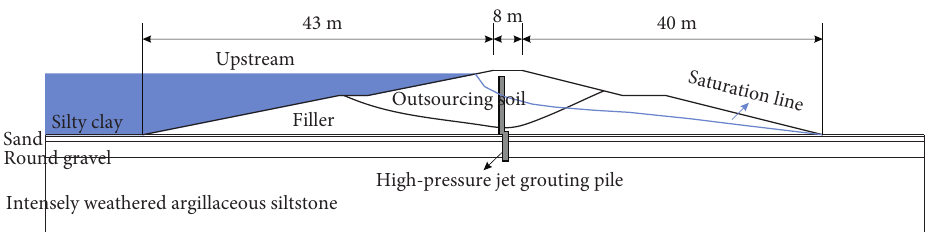
Figure 2: Lateral section of the upstream closure section of the cofferdam.